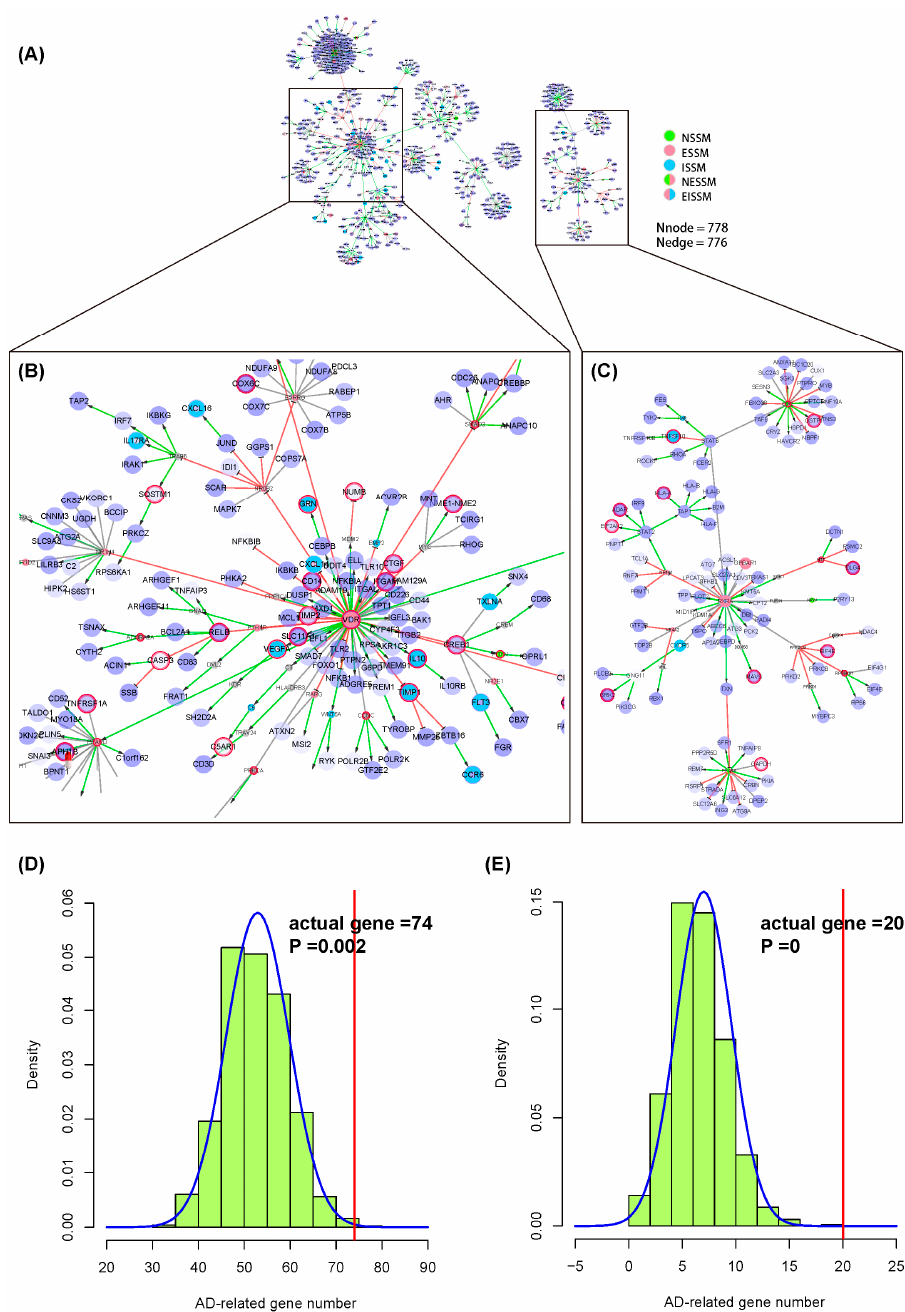
Figure 4. The application of the neuroendocrine immunomodulation (NIM) molecular network in the interpretation of the disease pathogenesis. ( A ) The overall graph of Alzheimer’s disease (AD)-specific NIM subnetwork. The big nodes with purple color are the DEGs. The deeper the color, the higher the fold change in the differential expression of the genes; the small nodes are the non-DEGs. In addition, the nodes with a red circle are RA-related genes. The meanings of the other network elements are the same as shown in Figure 1. ( B , C ) The partial enlargement network graph of ( A ); ( D ) The probability density curve of the number of AD-related genes obtained from DEGs by the permutation test; ( E ) The probability density curve of the number of AD-related genes obtained from non-DEGs by the permutation test. The AD-related genes are the biomarkers dataset of AD downloaded from the MetaCore database. The red vertical line is the actual number of AD-related genes in the AD-specific NIM